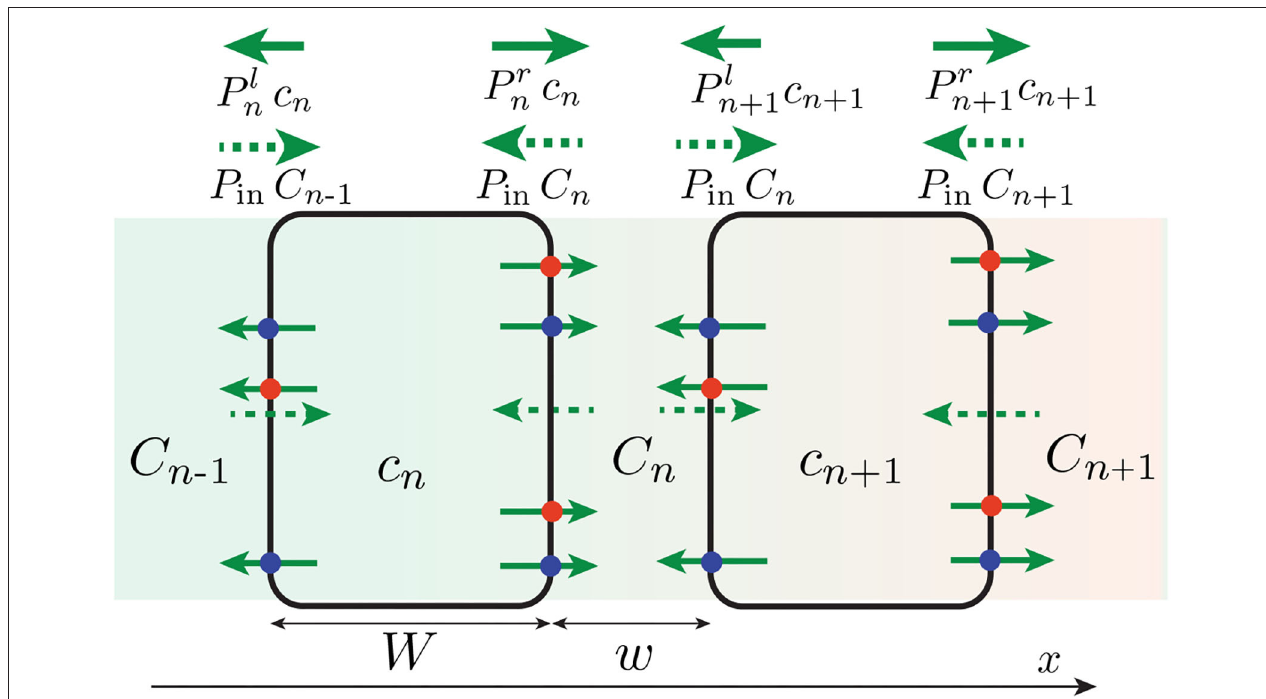
W ). Efflux of auxin (solid green arrow) occurs through efflux carriers ≪ P r can generate a net flux of 6=